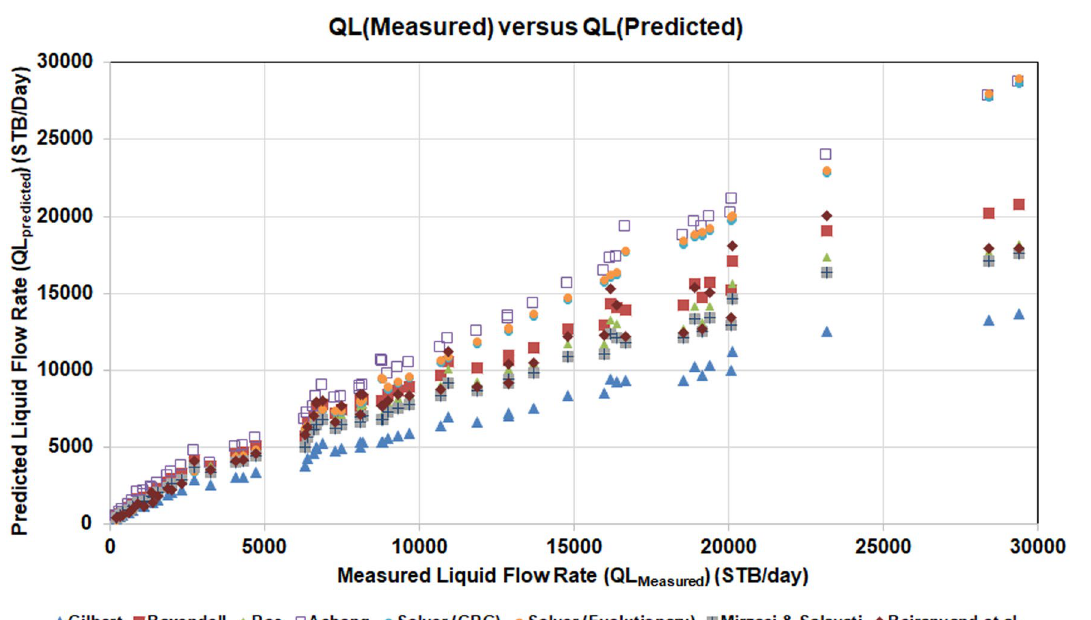
Fig. 8 Liquid flow rate Q Q (1961), Beiranvand et al. (2012), and Mirzaei-Paiaman and Salavati L(predicted) versus L(measured) achieved by (2013) to the Reshadat oil field applying Eq. (19) with appropriate applying the two Excel Solver optimization algorithms (non-linear coefficients to the test data subset (55 data and evolutionary) and the published liquid flow-rate prediction for- mulas of Gilbert (1954), Baxendell (1958), Ros (1960), Achong